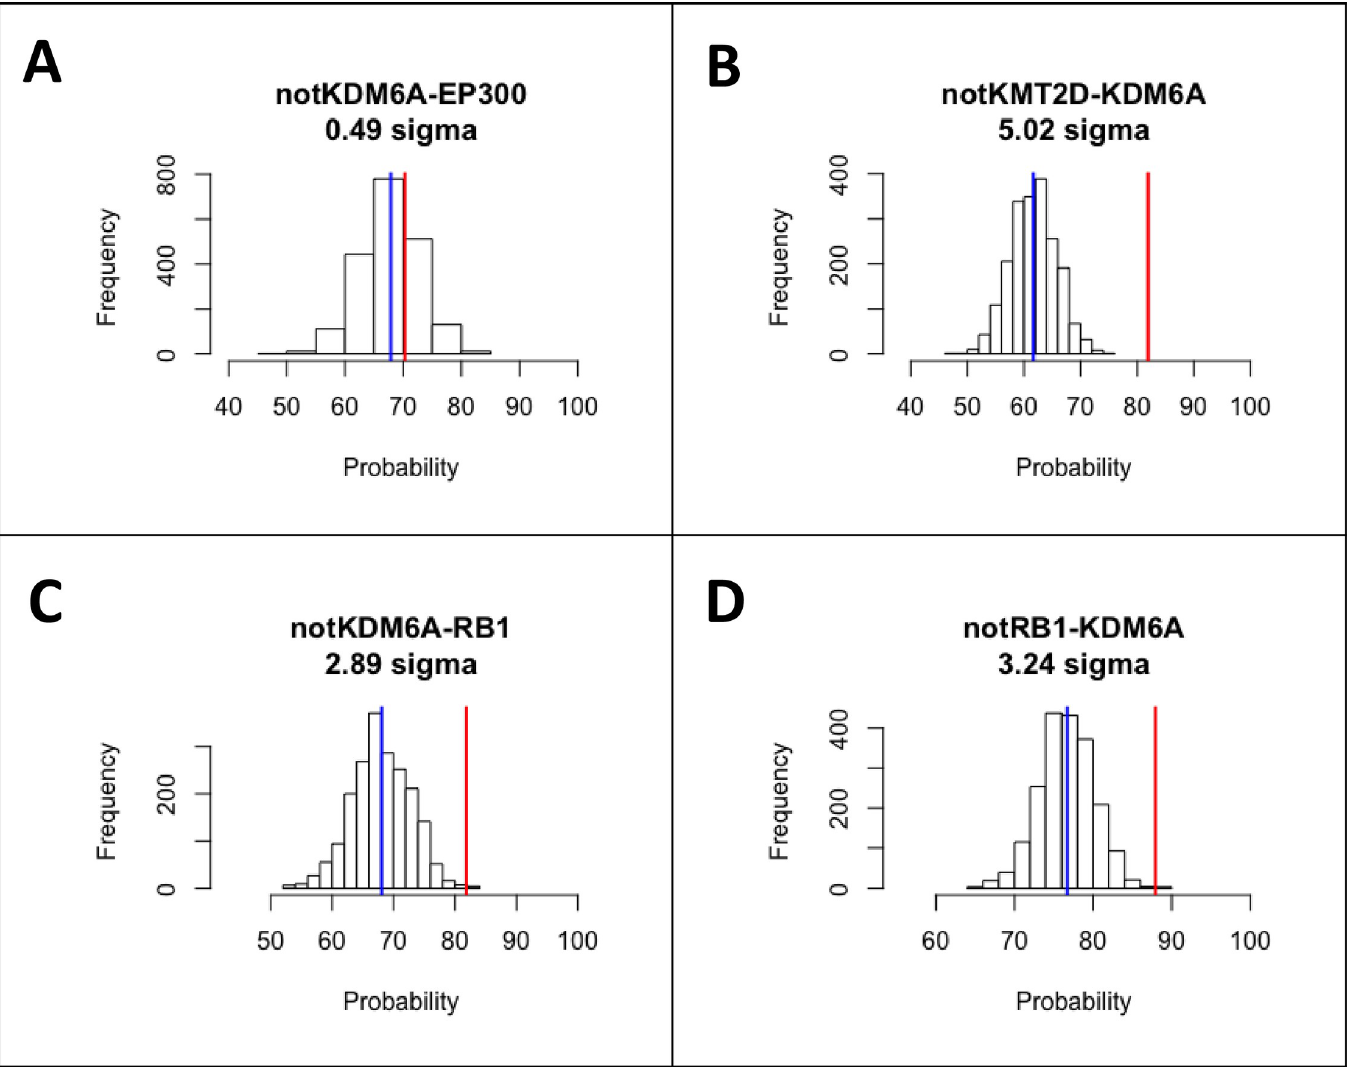
Fig 4. Representative differences in statistical significance of conditional probability for different gene pairs. The red bar is the mean of the RGCP distribution, and the blue bar is the value observed in the CP matrix. (A) A relationship where there is no statistically significant difference between RGCP distribution and the observed value, between the KDM6A mutation and no mutation in EP300. (B) A statistically significant relationship, where RGCP distribution for having KDM6A mutation and no mutation in KMT2D is significantly different from the observed value. (C and D) A statistically significant, bidirectional relationship, where the presence of an RB1 mutation and absence of a KDM6A mutation, and the (opposite) absence of an RB1 mutation and presence of a KDM6A mutation are both observed at frequencies significantly different from the predicted RGCP distribution.